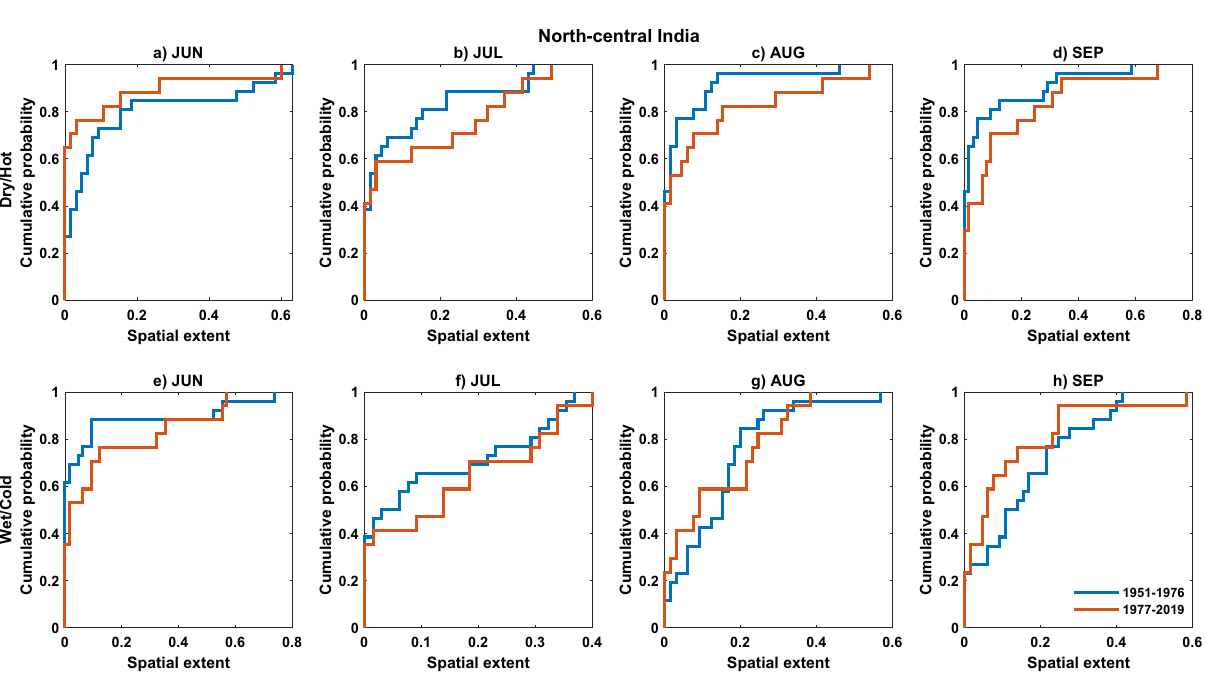
Figure 7. Empirical CDF of CDHE ( a – d ) and CWCE ( e , f ) spatial extent during June, July, August and September for the recent period (1977–2019) versus base period (1951–1976) for North-central India. This figure is generated in MATLAB R 2020b (Version 9.9 https:// in. mathw orks.